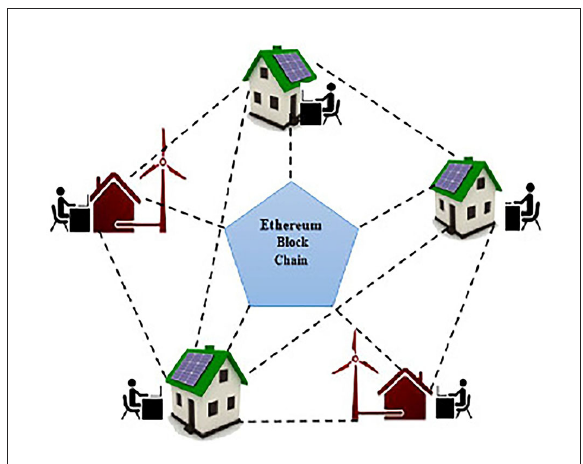
FIGURE14 Architecture of proposed blockchain and IoT based P2P energy trading platform (Baig et al., 2020).